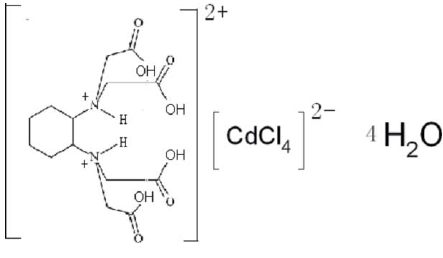
Data collection Siemens SMART CCD area- detector diffractometer Absorption correction: multi-scan ( SADABS ; Sheldrick, 1996) T min = 0.472, T max = 0.712